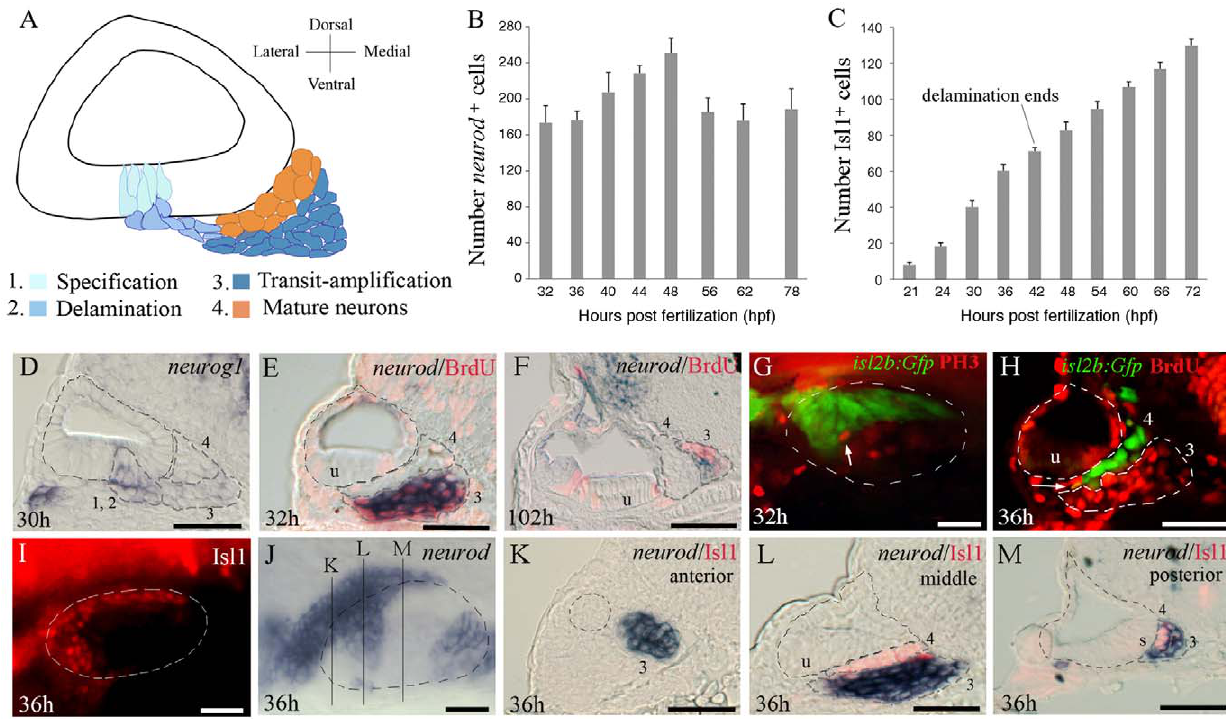
Figure 1. Development of Statoacoustic Ganglion (SAG). (A) Illustration showing the various stages of SAG development. Neuronal precursors (neuroblasts) are specified (1) and delaminate from (2) the floor of the otic vesicle. Neuroblasts undergo a phase of transit-amplification (3) wherein they migrate to a position between the otic vesicle and hindbrain as they continue to proliferate. Neuroblasts finally differentiate into mature neurons (4). (B) Total number of delaminated neurod + cells within the SAG counted from serial sections at the indicated times (mean 6 standard deviation, n=2 or greater for each time point). (C) total number of Islet-1-positive SAG neurons at the indicated times (mean of total number 6 standard deviation, n=20 for each time point). (D) neurog1 expression at 30 hpf. (E, F) Co-staining for neurod (blue) and BrdU (red) in embryos exposed to BrdU for 6 hours starting at 26 hpf (E) and 96 hpf (F), and then fixed at 32 hpf and 102 hpf, respectively. (G) Co-staining for isl2b:Gfp (green) and phospho-histone H3 (PH3, red) at 32 hpf. Only one mitotic cell (arrow) is seen in the vicinity of the SAG. (H) Co-staining for Islet1 (green) and BrdU (red) at 36 hpf. Only one double-stained cell is visible (arrow). (I–M) Expression of neurod (blue) and Islet-1 (red) at 36 hpf. Mature neurons are labeled with Islet-1 (I) and delaminated progenitor cells express neurod (J). Positions of section-planes in K–M are indicated in (J). (K–L) Transverse sections passing through the anterior (K), middle (L) and posterior (M) regions of the SAG show mostly complementary patterns of neurod and Islet-1. The outer edge of the otic vesicle is outlined in all panels. SAG cells in stages 1–4 of development are indicated in sections, and the position of the utricular macula (u) is indicated. Images of whole-mount specimens (G, I, J) show dorsolateral (G, I) and dorsal (J) views with anterior to the left. Images of transverse sections (C–F, H, K–M) show dorsal to the top and lateral to the left. Scale bar, 25 m